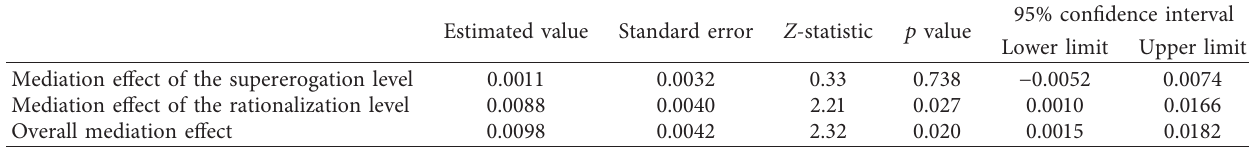
Table 8: Mediation effect results obtained by the Bootstrap method.